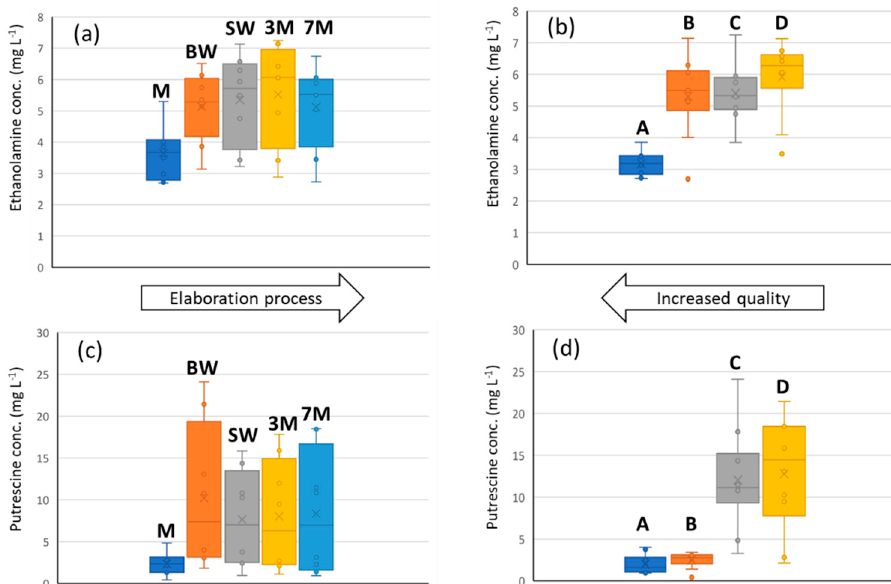
Figure 3. Boxplots with whiskers representing the concentration of ethanolamine and cadaverine in the samples. ( a ) Ethanolamine as a function of the sample types; ( b ) Ethanolamine as a function of the qualities; ( c ) Putrescine as a function of the sample types; ( d ) Putrescine as a function of the qualities. Sample assignment: M = must; BW = base wine; SW = stabilized wine; 3M = sparkling wine of 3 months aging; 7M = sparkling wine of 7 months aging. A = quality A; B = quality B; C = quality C; D = quality D. Error bars indicate the minimum and maximum values.